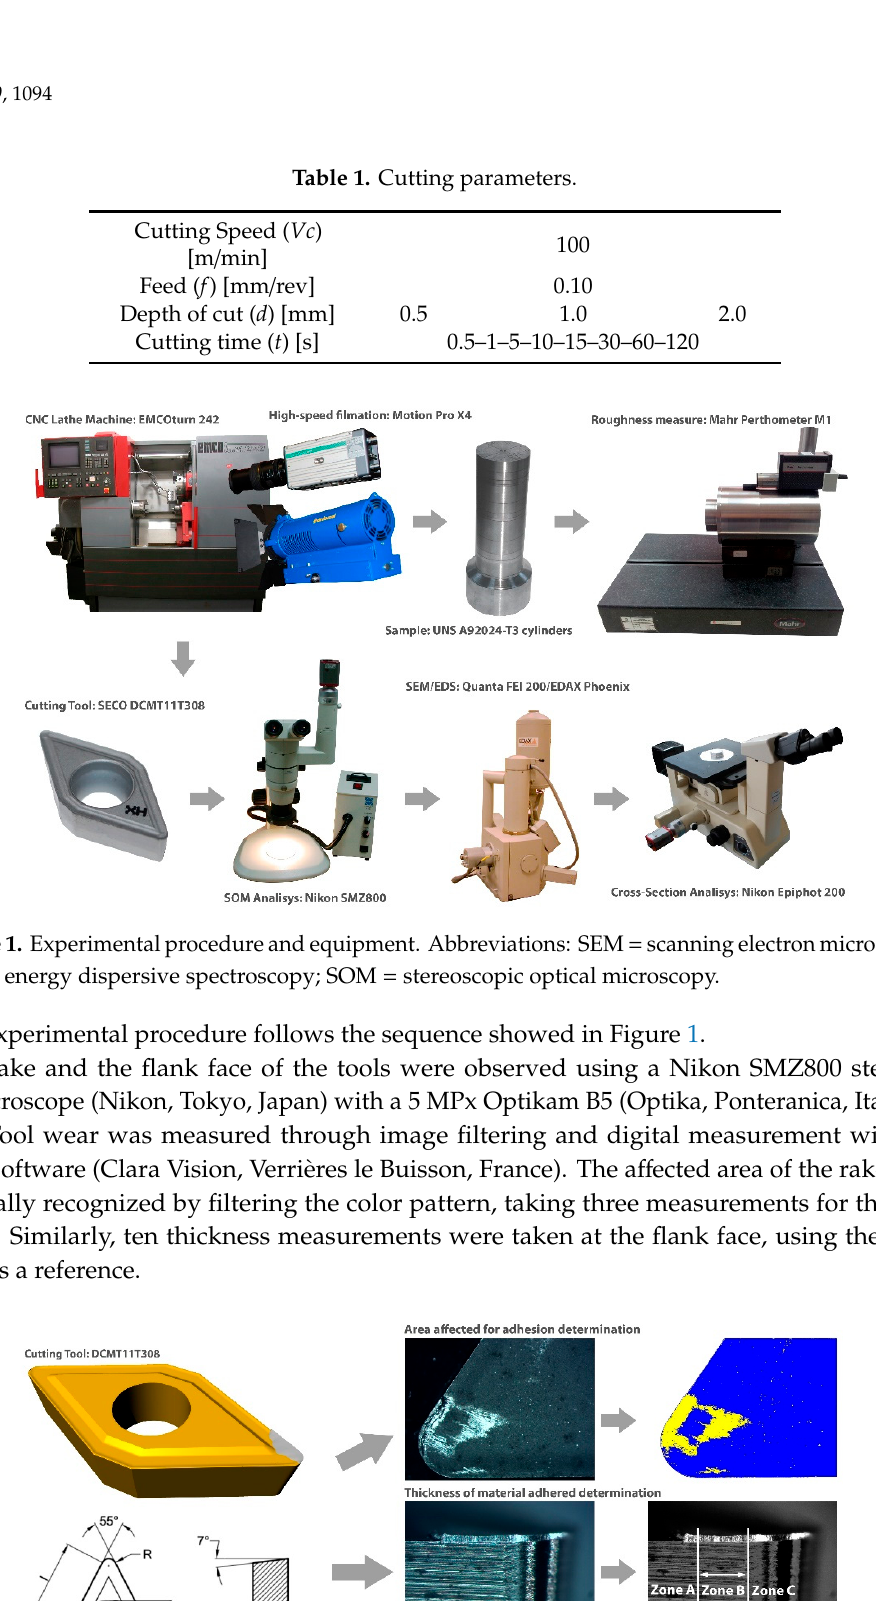
Table 1. Cutting parameters.